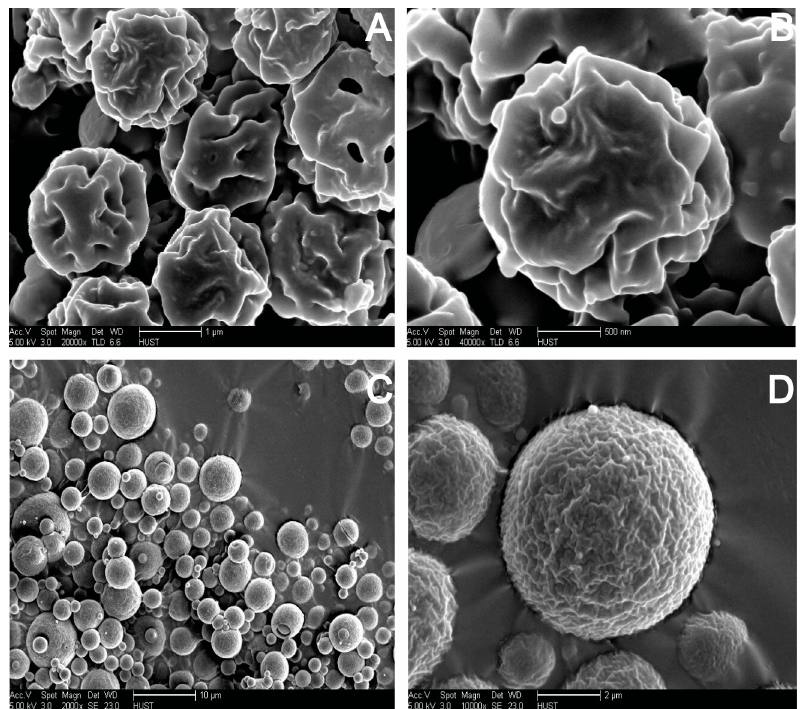
Figure 5. SEM images of S-SMEDDS maltodextrin ( A : × 20000, bar = 1 μ m; B : × 40000, bar = 500 nm), and acacia ( C : × 2000, bar = 10 μ m; D : × 10000, bar = 2 μ m).